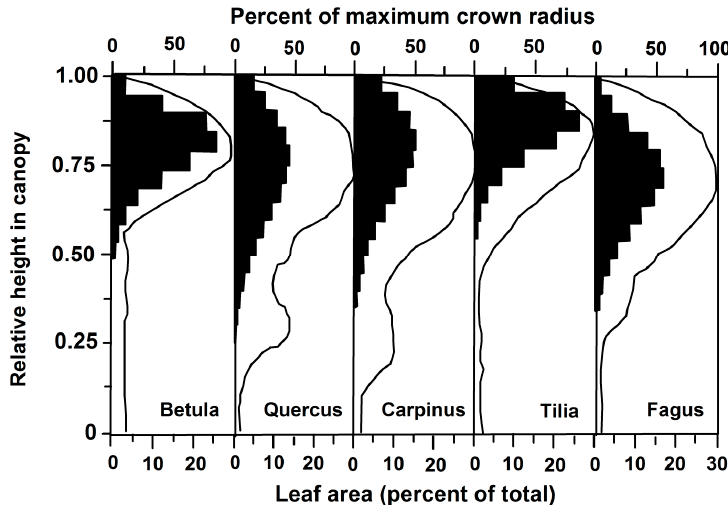
Figure 5. Leaf area distribution in dependence on height in the canopy in the five tree species (black bars) (leaf-area-per-height level in percent of the tree’s total). Also indicated is the relative volume of the canopy along the stem axis (black line), that is the mean canopy radii in percent of maximum canopy radius. Based on the analysis of each of the four tree individuals per species with typical dbh and height in the canopy that were analyzed for their crown dimensions with the canopy window and were subsequently harvested with their foliage.